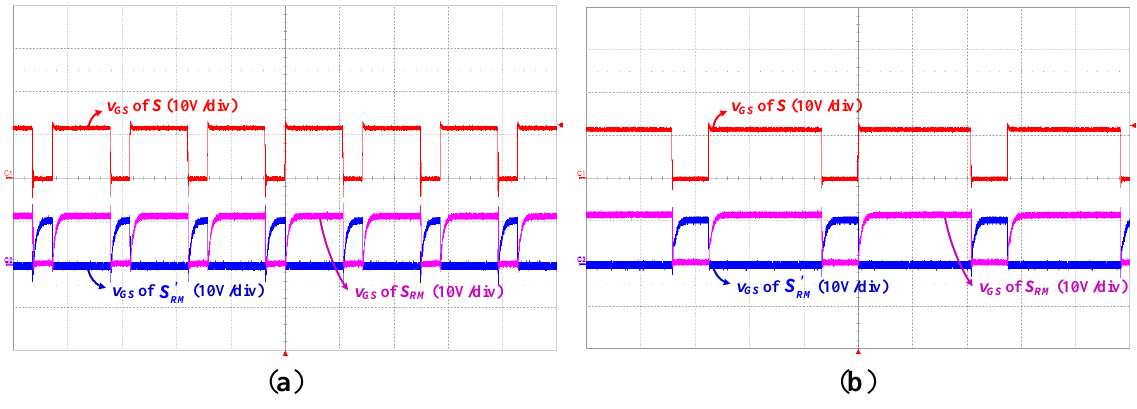
Figure 12. Gate signal waveforms of the proposed converter under ( a ) half, and ( b ) full load conditions (50 ms/div).